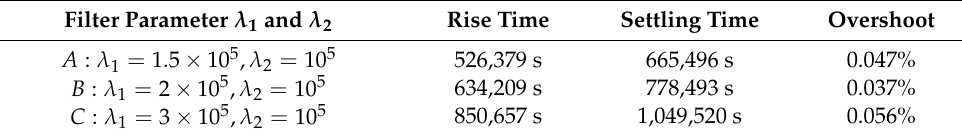
Table 4. Effect of filtering parameter 1